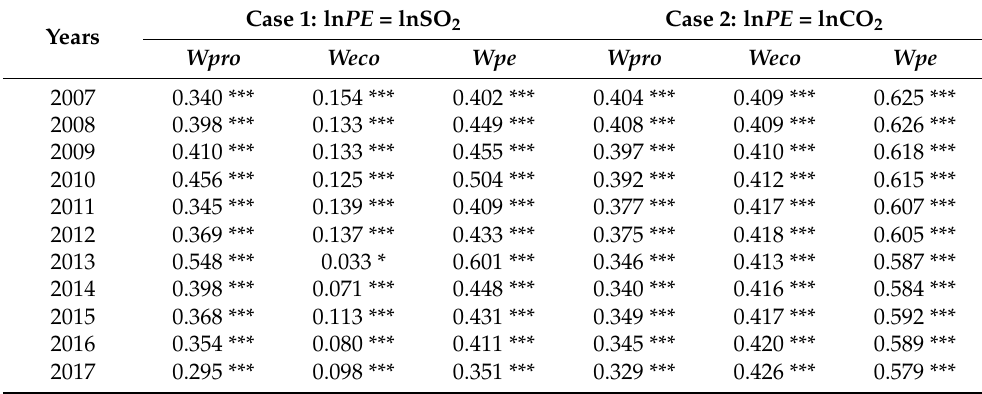
Table 3. Test results of Moran’s I for global spatial dependence (2007–2017).